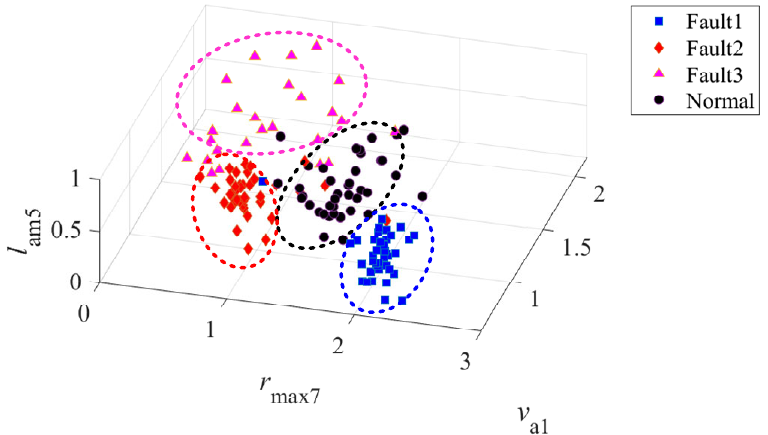
Figure 8. Distribution of samples in the feature space. Table 4. Feature selection results.